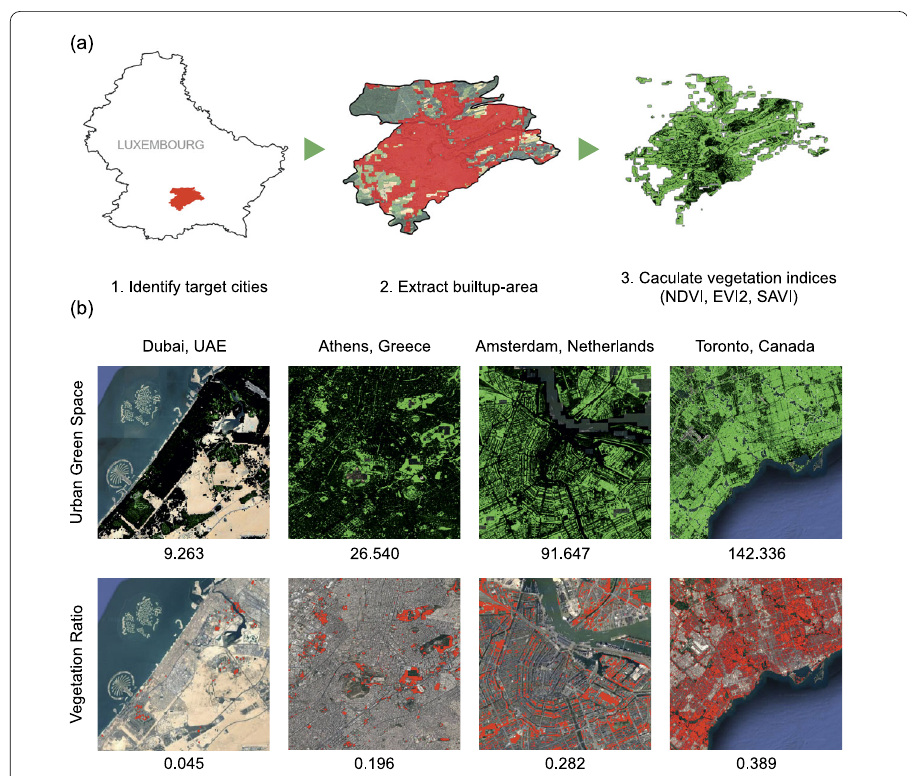
Figure 4 Measuring urban green spaces. ( a ) Measurement methods to compute the size of urban green space in each country. First, we find cities occupying more than 10 percent of the total population in a country. Then, we extract the built-up area of the cities with Copernicus global landcover data. Finally, we calculate vegetation indices (e.g., NDVI) within the area using Sentinel-2 satellite images. ( b ) Urban green space measured by the UGS (upper row) and the vegetation ratio (lower row) in four world cities. The red areas in the upper row indicate vegetation for the NDVI threshold of 0.4. The lower row images show the adjusted NDVI per capita (i.e., UGS) for every 10m by 10m